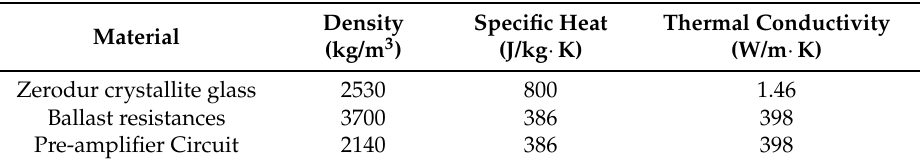
Table 1. Thermal parameters of materials in ring laser gyro (RLG) assembly.